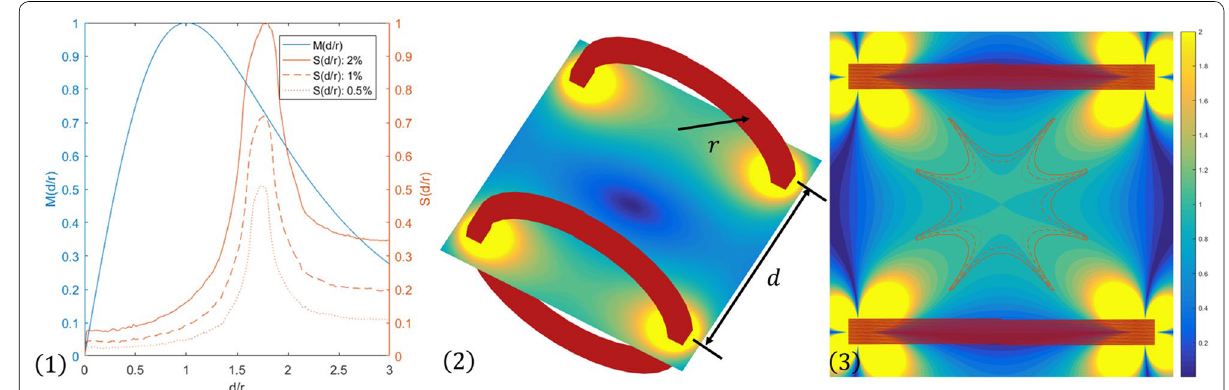
Figure 8 Optimization result for the loop-shaped coil pair inducing uniform gradient